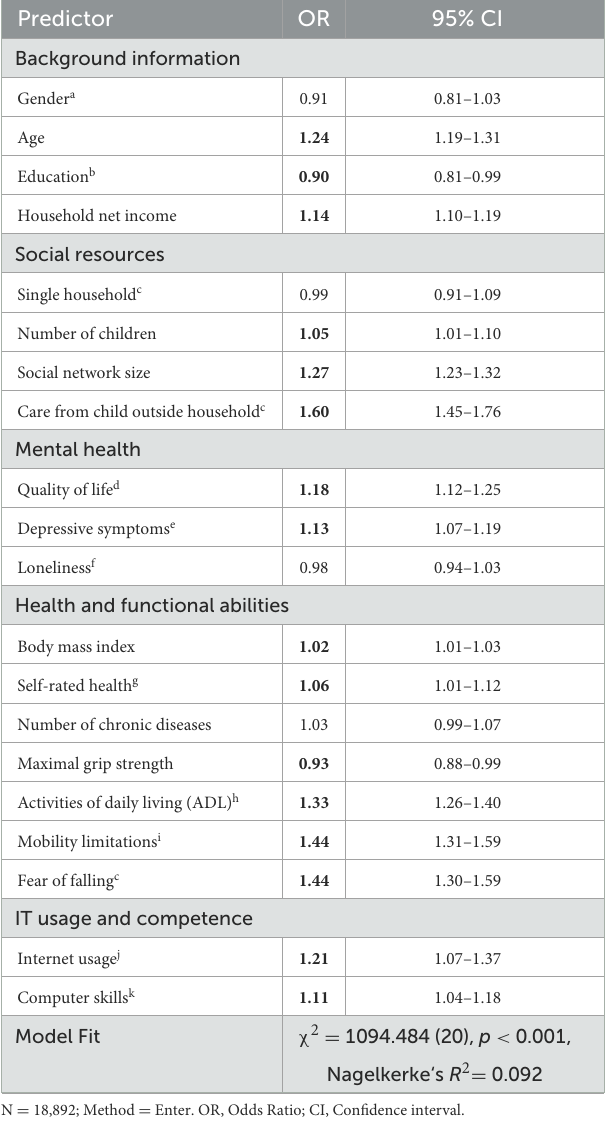
TABLE 2 Logistic regression analysis explaining the implementation of technology-based home modifications for the total sample (65 +